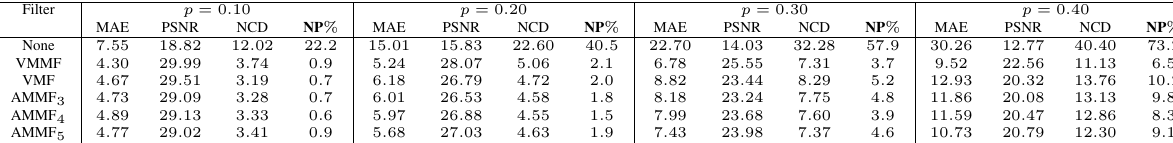
Table 1. Performance comparison in terms of MAE, PSNR, and NCD when filtering the Boats image contaminated with random-value impulse noise with probability p in each colour channel.